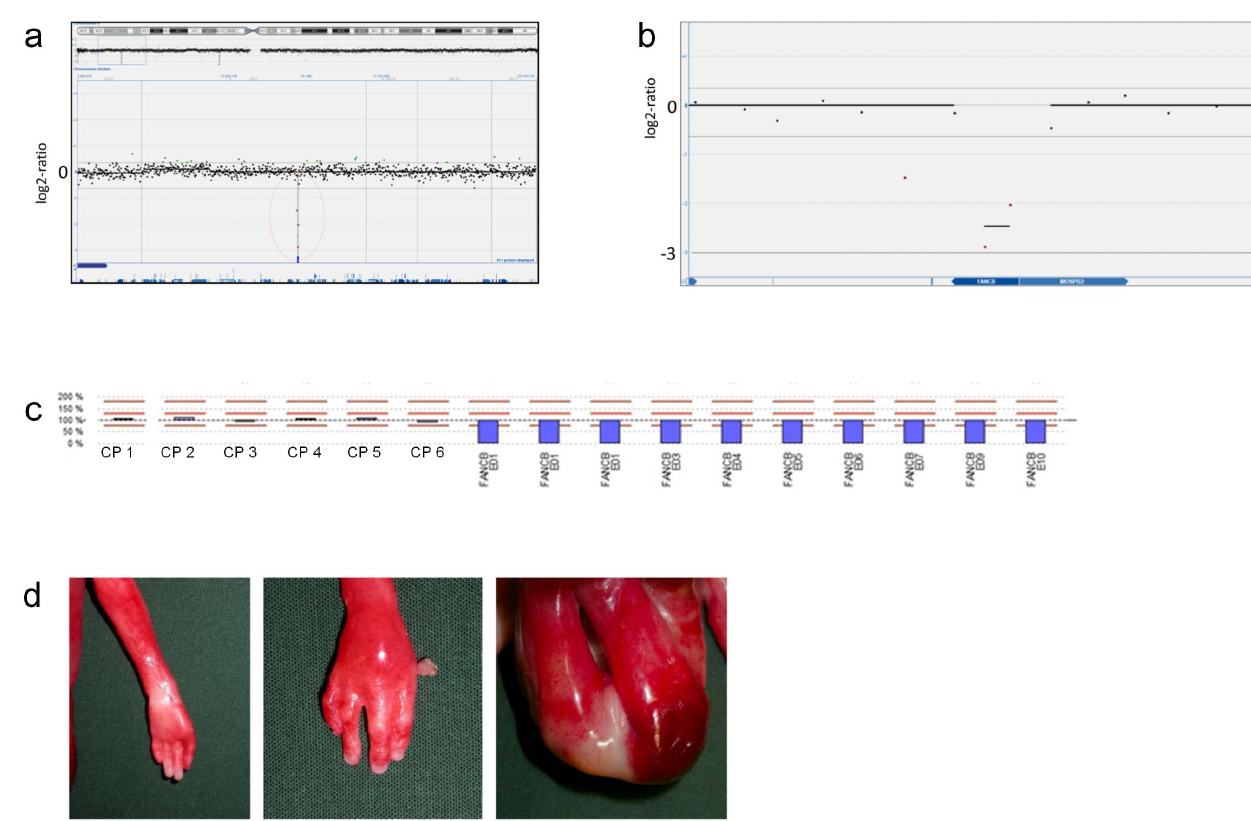
Figure 2. Results from array-CGH and MLPA analysis on genomic DNA from fetal case FC10. Upper images show a hemizygous deletion (mean log2-ratio -2.5) on Xp22.2 comprising two probes located within the FANCB gene consistent with a diagnosis of X-linked VACTERL (a, b). Results from MLPA analysis of FANCB in fetal case FC10 (c). Y-axis scale with 100% representing a normal copy number and values above and below representing duplications and deletions respectively (0% representing homo-/hemizygous deletion). Results shown as blue bars emanating from baseline (100%). Analysis results in FC10 showing six control probes with normal copy number and hemizygous deletions of all FANCB exons. Lower images show malformations identified in fetal case FC10: left thumb agenesis (left), right thumb hypoplasia (middle) and imperforate anus (right) (d).